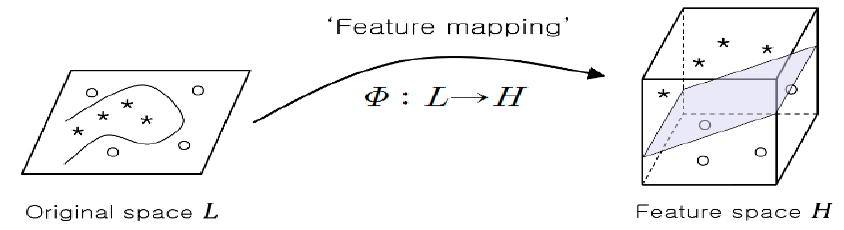
Figure 6. Use of feature map for non-separable problem.